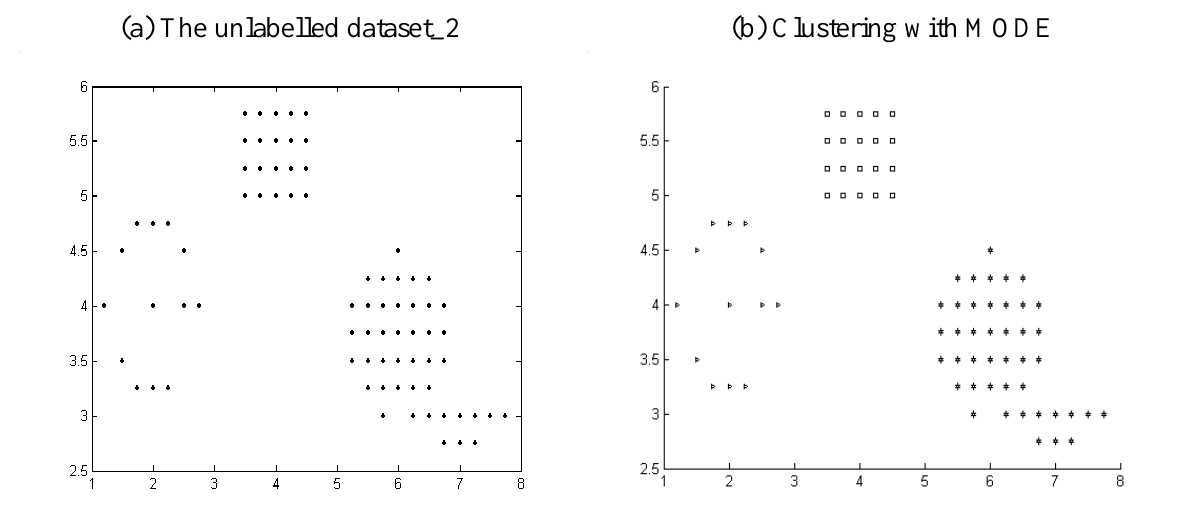
Figure 5. Clustering result for artificial dataset_2.